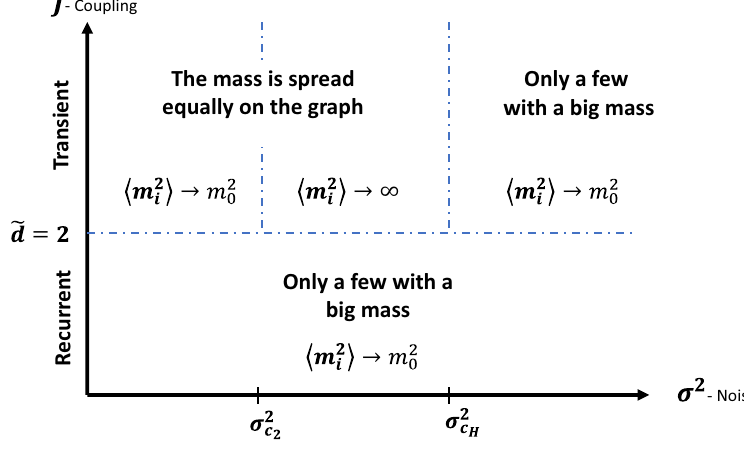
Figure 2. Sketch of the phase diagram of the